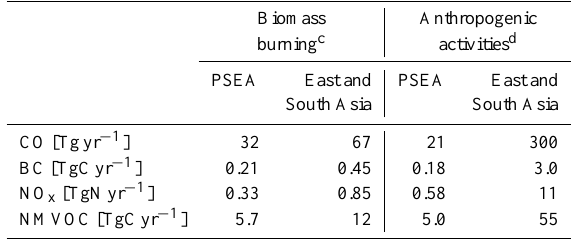
Table 1. Annual biomass burning and anthropogenic emissions from PSEA a and from the entire East and South Asia b